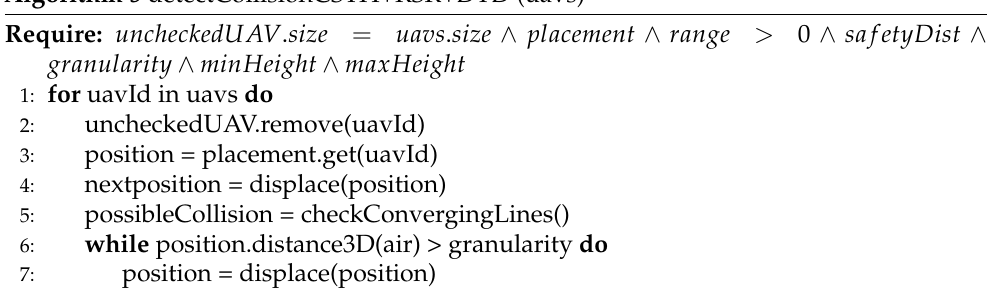
Algorithm 5 detectCollisionCSTH+RSR+DTD